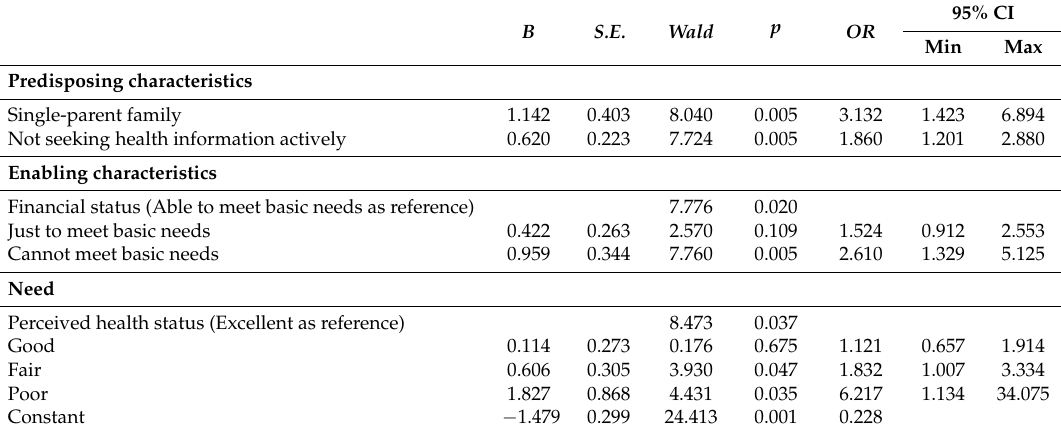
Table 3. Risk factors associated with mental health problems for migrant children in the multivariate logistic regression model 1